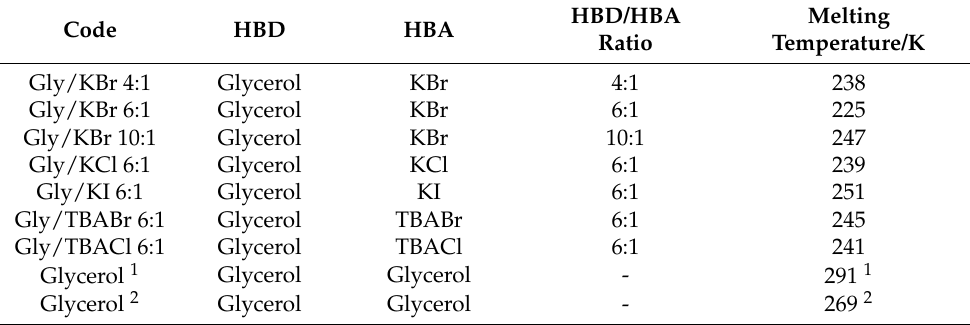
Table 1. Melting temperature of the different DES-like systems investigated within the